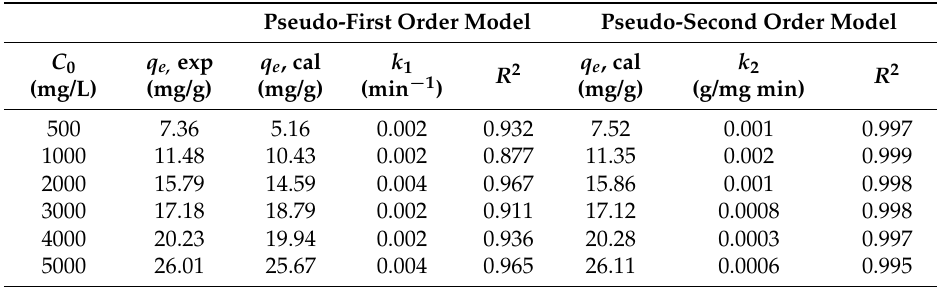
Figure 3. Effect of initial ammonium concentration on the removal of NH 4+ -N by the zeolite (T = 25 ◦ C, 200 rpm, 50 g zeolite/L, 4–5mm). Error bars indicate standard deviation of triplicate measurements. Table 3. Fitting kinetics parameters of adsorption of ammonium onto zeolite according to pseudo-first order and pseudo-second order models at various N-NH 4+ concentrations (zeolite granulometry: 4.0–5.0 mm).